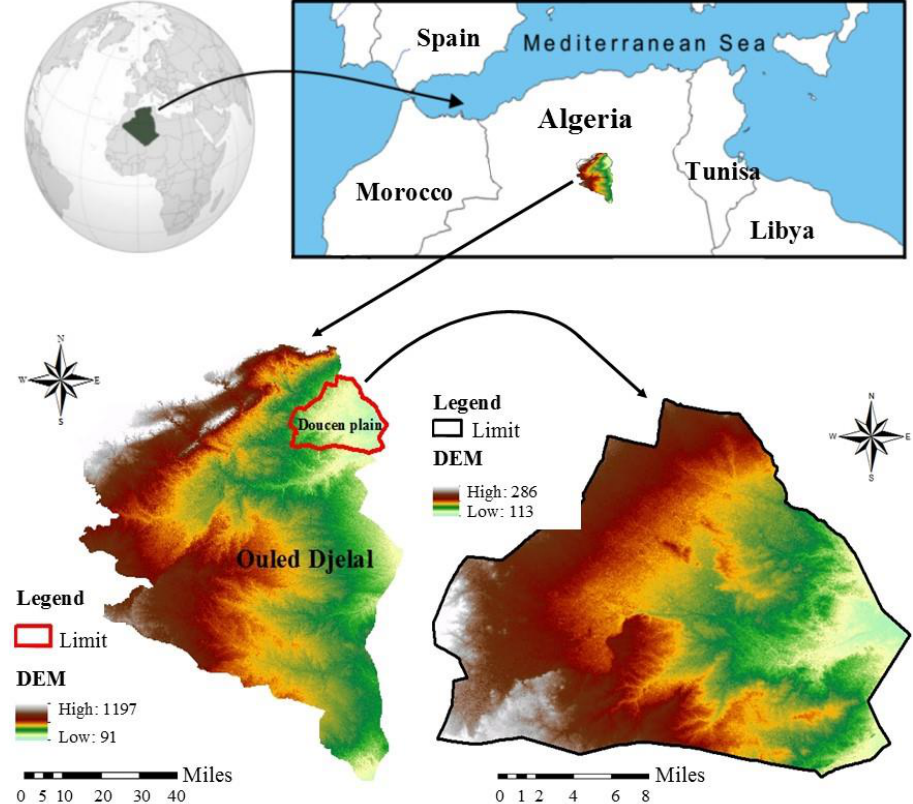
Figure 1. Map of the study area (Doucen plain, Algeria).